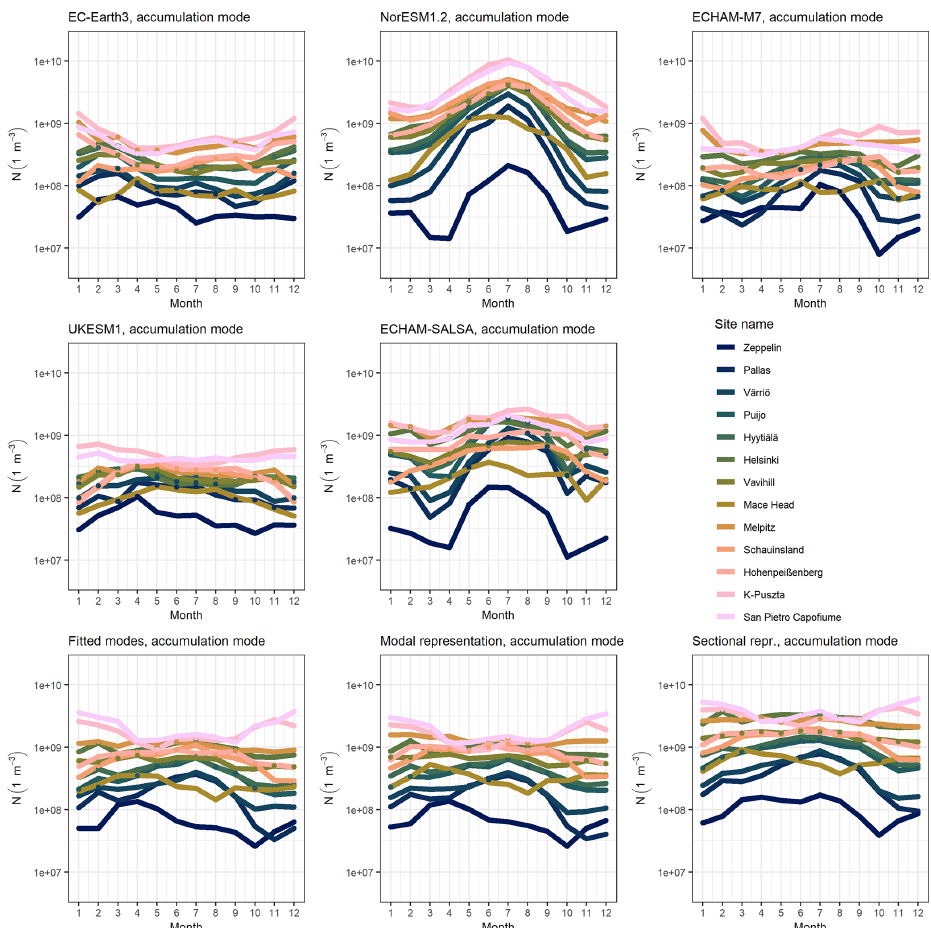
Figure 12. The seasonal cycle of accumulation mode number concentration in measurements and climate models for measurement sites. A subplot represents the seasonal cycle in one model or measurement. Coloured lines represent the median of the monthly means for accumulation mode number concentrations. Sites are ordered from most northerly to most